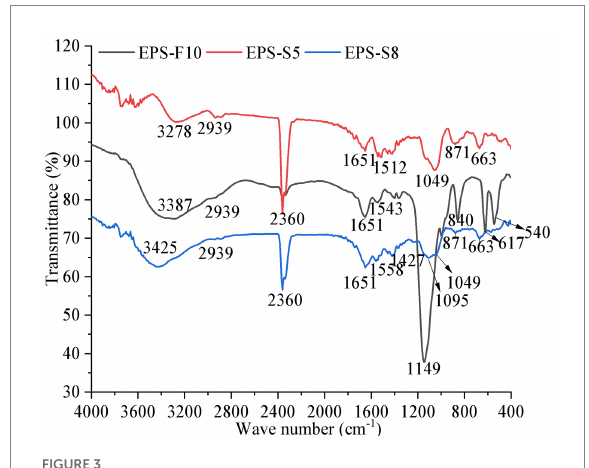
FIGURE 3 The Fourier infrared spectrum of EPS from three strains.